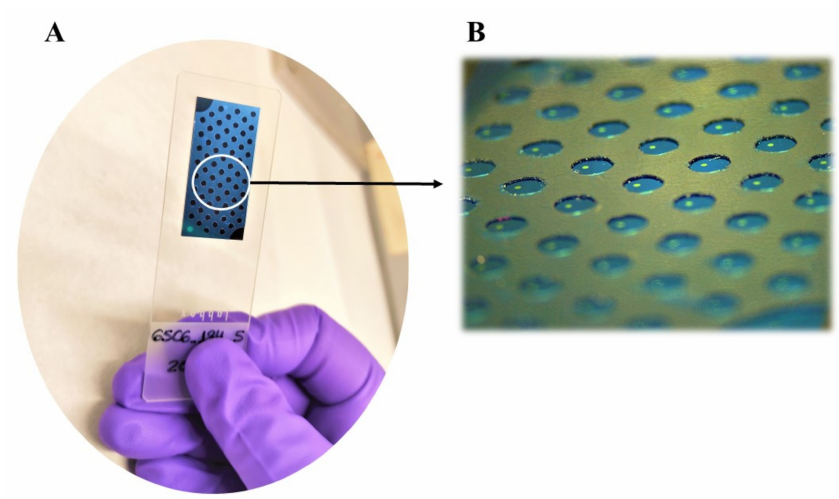
Figure 1. ( A ) Multiplexed 65-well KIT used for the described assays. ( B ) Detail of the sensor used, highlighting the BICELLs in yellow surrounded by the PVC. Abbreviations: Biophotonic Sensing Cell (BICELL), Polyvinyl Chloride (PVC).